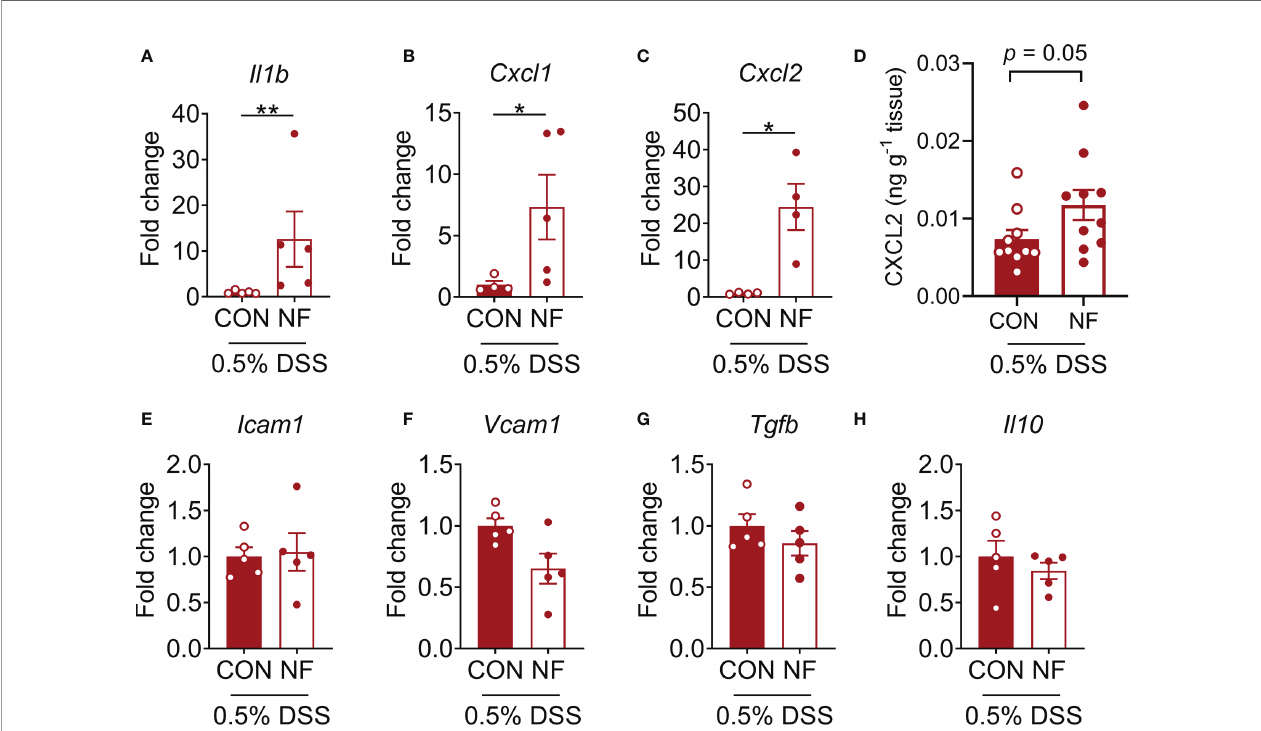
FIGURE 5 | Colonic cytokine and neutrophil recruitment pro fi les. WT mice were fed either a control (CON) or no fi ber (NF) diet for 14 days prior to and during 7 days of 0.5% DSS-induced colitis. At experimental endpoint, RNA was isolated from the colon, and expression of (A) Il1b , (B) Cxcl1 , (C) Cxcl2 (E) Icam1 , (F) Vcam1 , (G) Tgfb and (H) Il10 were assessed. Data was normalized to CON DSS group, presented as mean ± SEM. N ≥ 4 per group, * P < 0.05, ** P < 0.01 with the Mann-Whitney U -test. At experimental endpoint, protein was isolated from the colon and levels of CXCL2 (D) was assessed. Data was presented as mean ± SEM. N ≥ 10 per group, P -value with the Mann-Whitney U